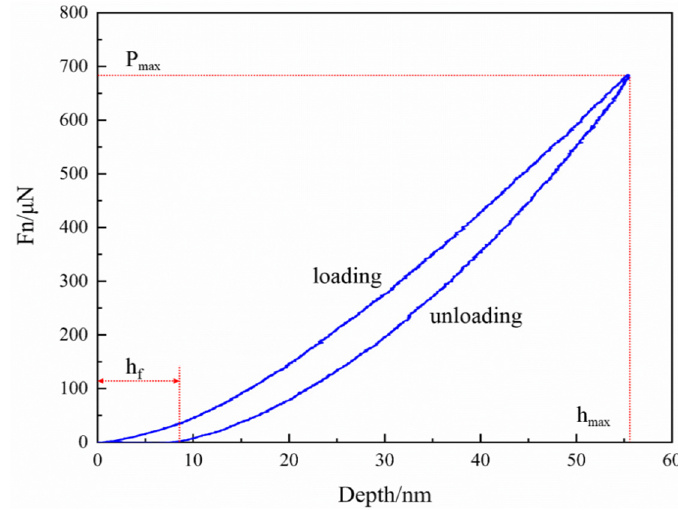
Figure 2. AFM image of h-BN coatings.